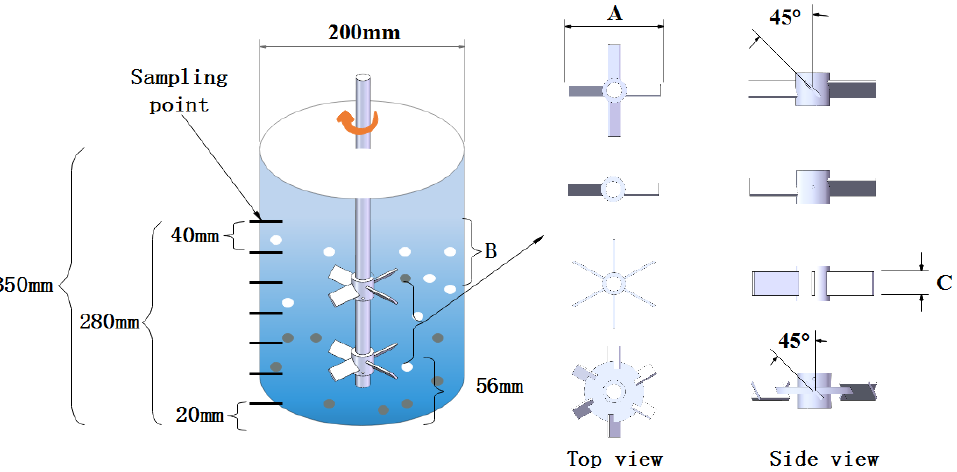
Figure 1. Digestion reactor and blade structure: (A) Diameter; (B) Immersion; (C) Width. The solid-liquid system consisted of liquid water (1000 kg/m 3 ), FP (950 kg/m 3 ), and SP (1050 kg/m 3 ). The average solid concentration was 5% by volume. The Euler multiphase flow model regards the two phases, solid and liquid, as mutually permeable media, and water was defined as a continuous phase. Moreover, SP and FP were infiltrated by water as dispersed phases, and fluid was considered incompressible.